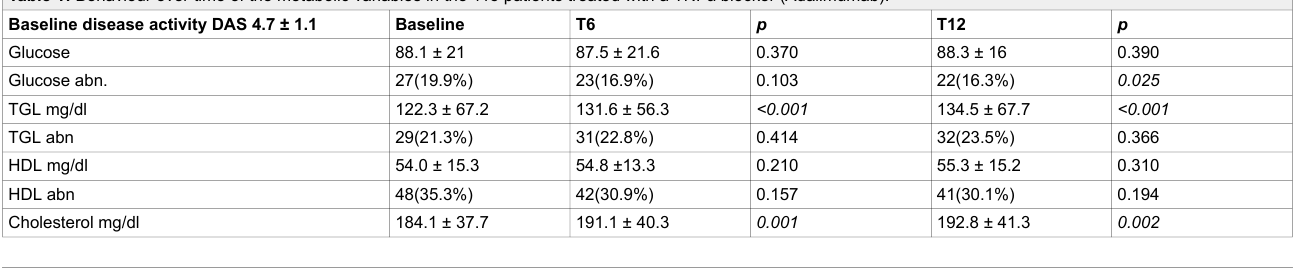
Table 2: Low disease activity according to the baseline metabolic abnormalities in the cohort of patients treated with a TNFα blocker.